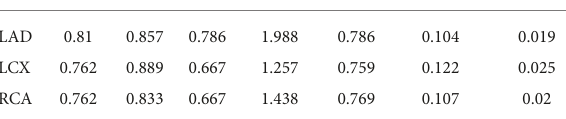
TABLE 2 Comparison of the difference in predictive ability between the calcification and the SUVmean FAPI uptake. ACC SEN SPE Cutoff AUC AUC.SE